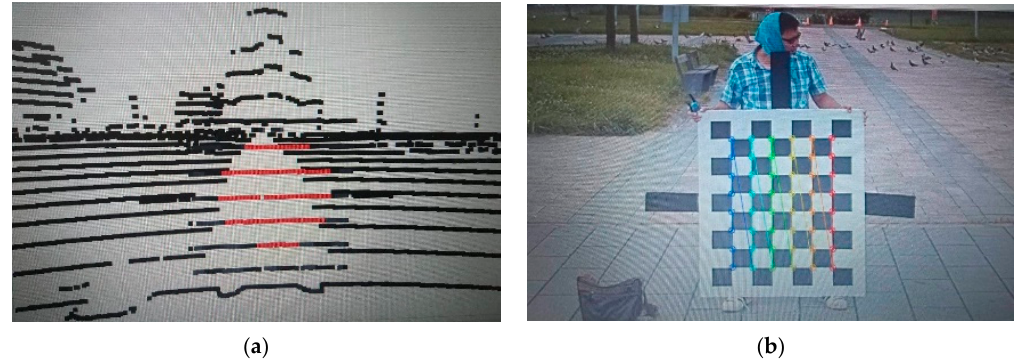
Figure 12. Calibration between Lidar scan and camera image ( a ) Lidar scan on calibration board ( b ) image of calibration board.